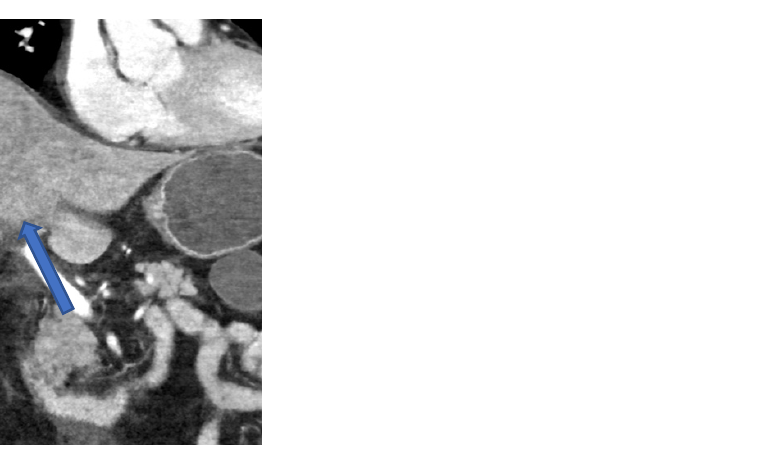
Figure 2. Liver biopsy (10× enlarged) in hematoxylin–eosin staining of ( a ) case 1 showing a multifo- cal, hepatocellular necrosis and viral inclusion bodies, and ( b ) case 2 showing an acute and extensive hepatocellular necrosis.